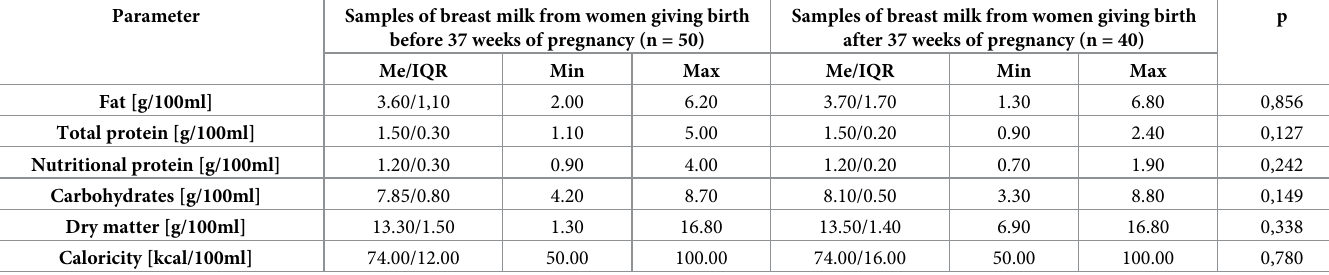
Table 1. Basic composition of breast milk from women giving birth before and after 37 weeks of pregnancy.